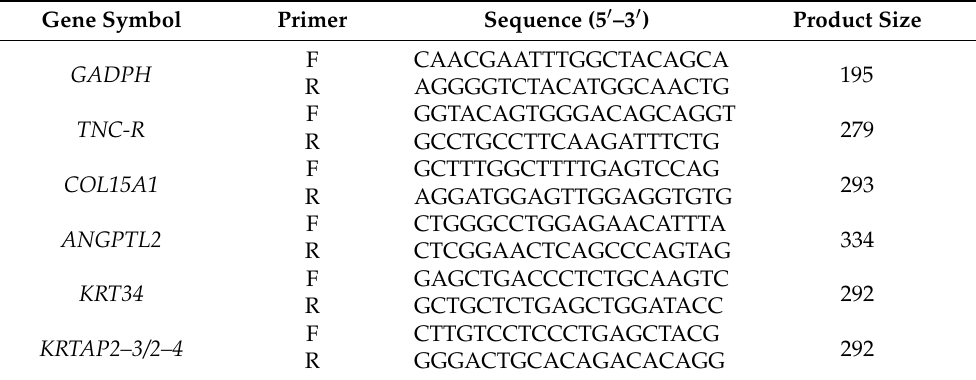
Table 1. Primers and product